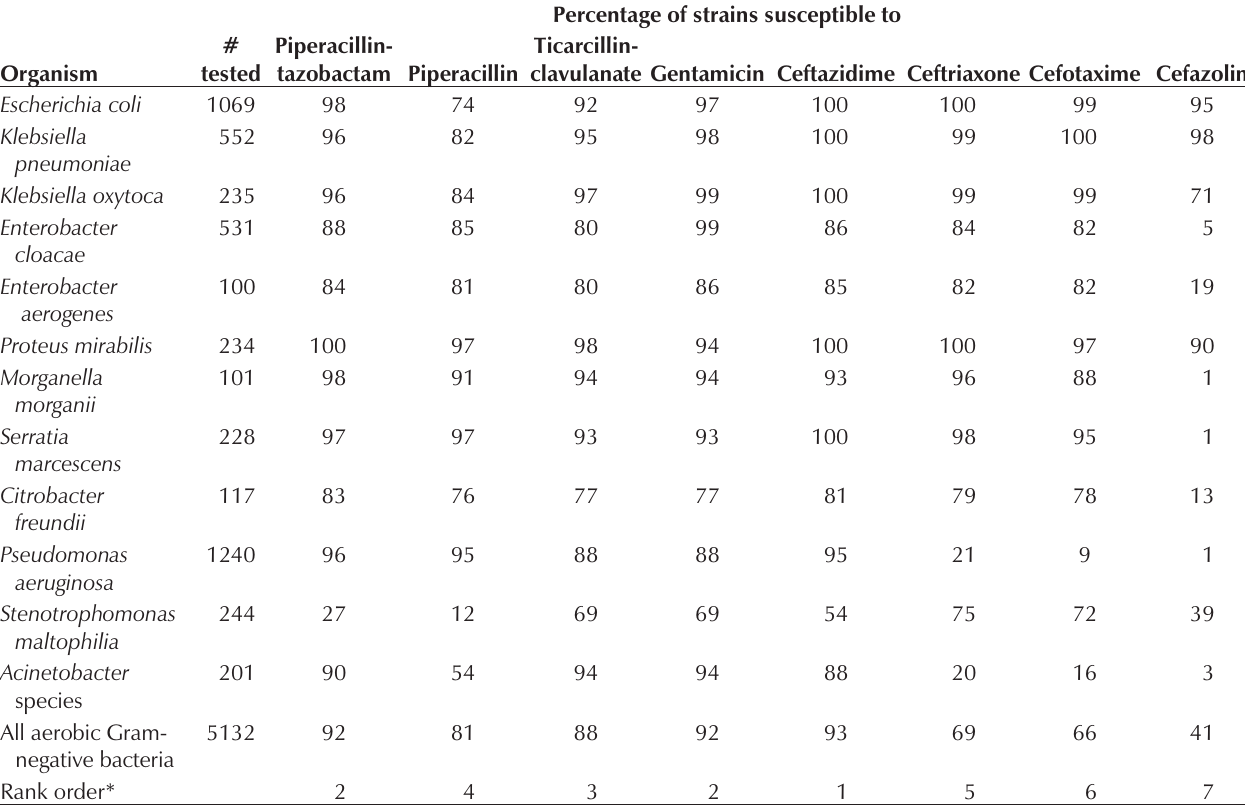
Percentage of strains susceptible to